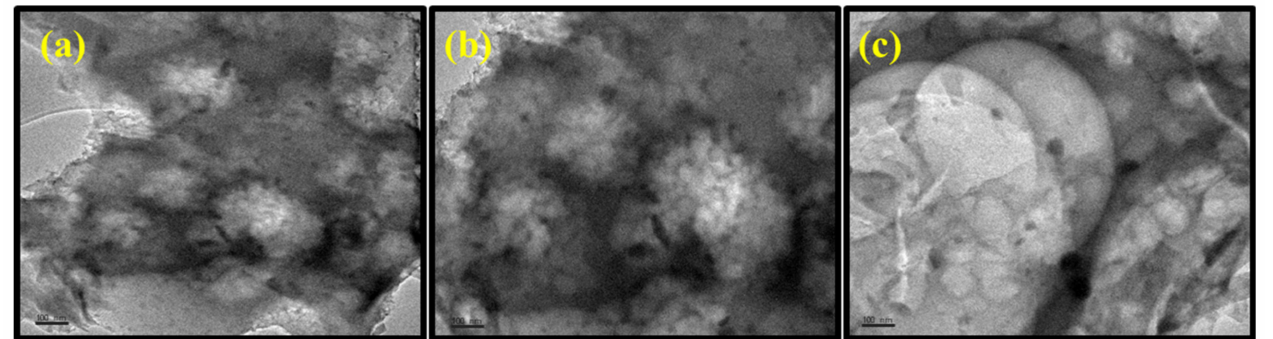
Figure 3. FESEM images with corresponding elemental mapping of ( a – d ) NRPC-700, ( e – h ) NRPC-800 and ( i – l ) NRPC-900.